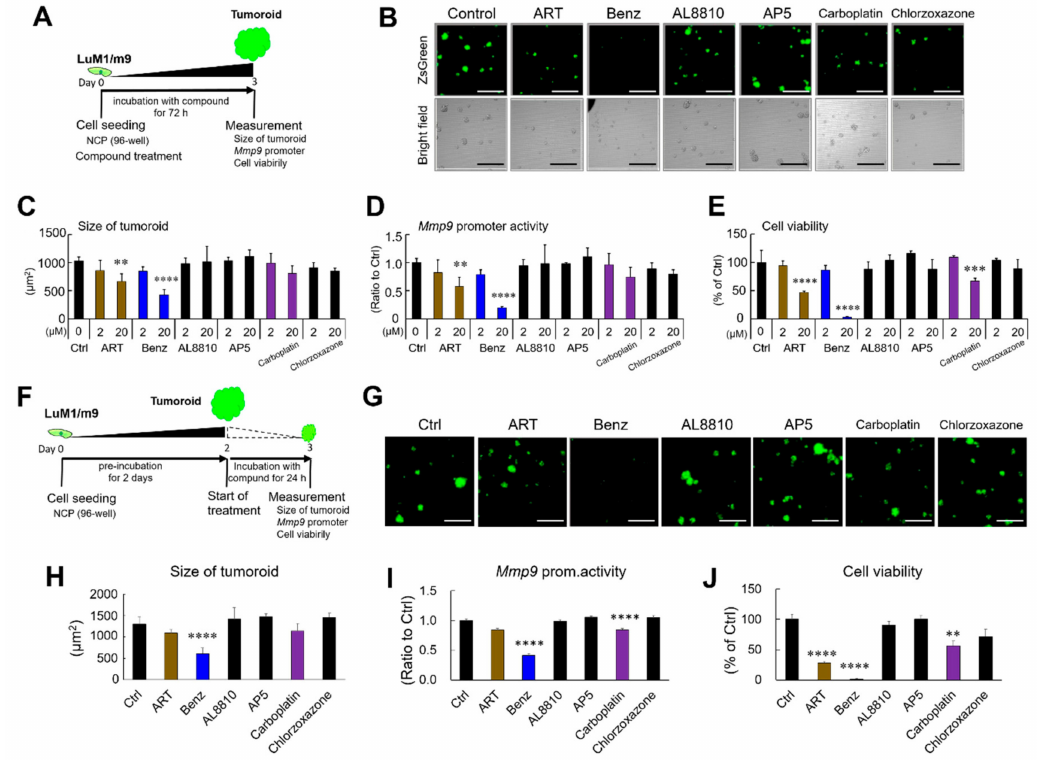
Figure 1. Tumoroid-based multiplex drug screening to target matrix metalloproteinase 9 (MMP9) promoter activity and cancer cell viability. ( A ) Schematic representation of the experimental